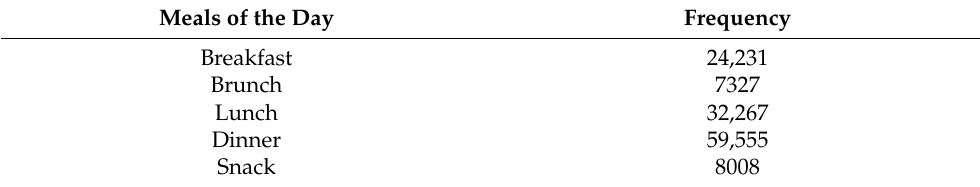
Table 2. Meals of the day tweeted in connection with the hashtag #foodblogger on Twitter. Meals of the Day